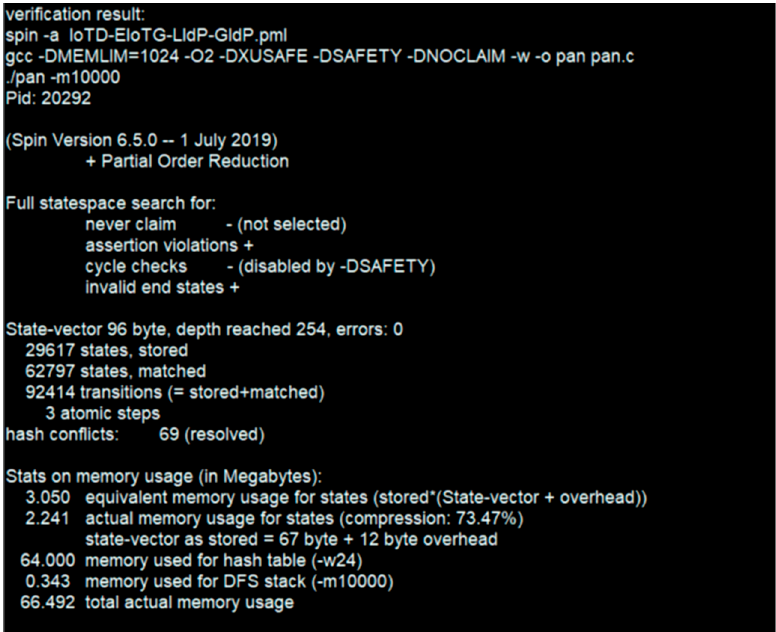
Figure 19. SPIN Verification results for communication between IoTD, EIoTG, LIdP and GIdP.